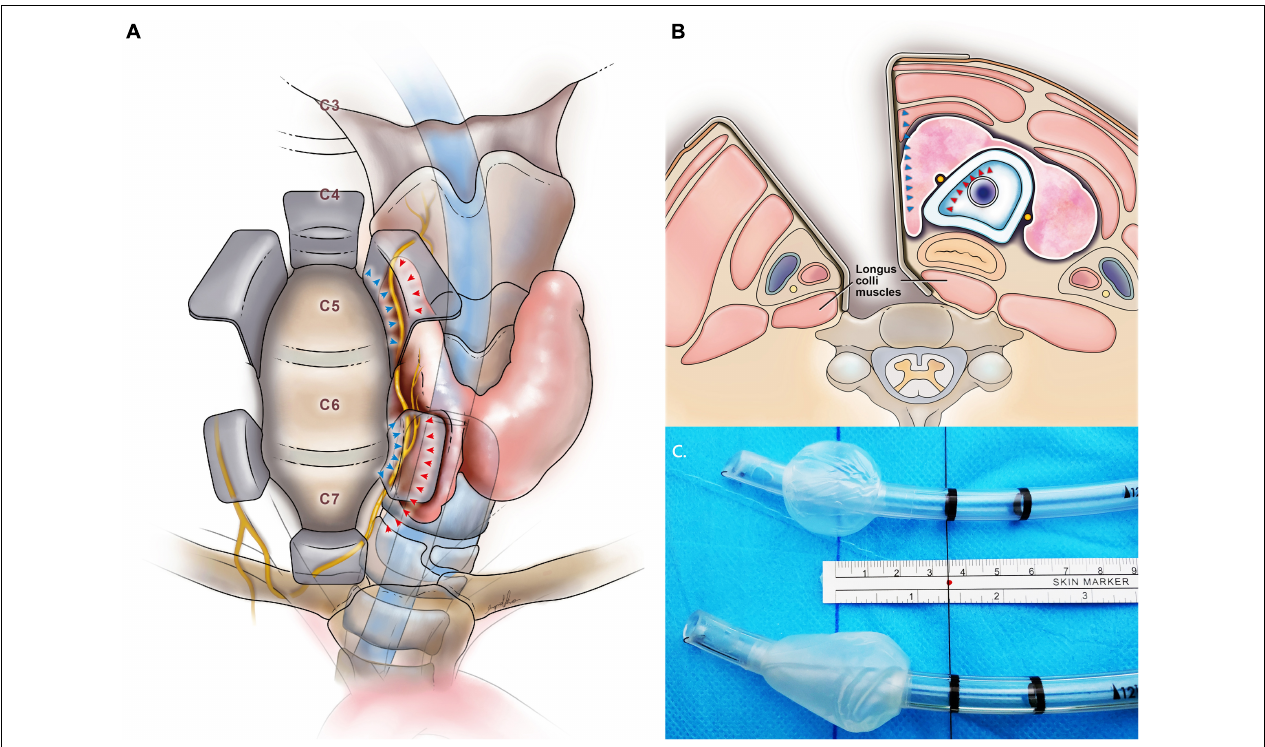
FIGURE 1 | (A) The anterior view shows surgical retraction during anterior cervical spine surgery. The retractor displaces the larynx against the unyielding tracheal tube shaft and cuff with compression on the recurrent laryngeal nerve (in yellow). The arrow indicates the force exerted by the retractor blade (blue) and tracheal tube cuff (red). (B) Cross-sectional neck anatomy shows the recurrent laryngeal nerve within the medial soft tissue complex between the force from the medial retractor blade (blue) and the tracheal tube cuff (red) when using the right-sided approach (seen from below). (C) The tracheal tube cuff shapes and the study groups: cylindrical cuff (i.e., control group, above) and tapered cuff tracheal tube (i.e., tapered group,